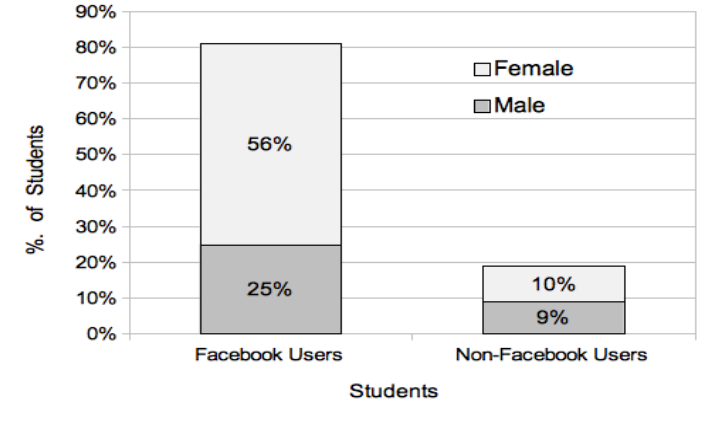
Figure 2 . Student Facebook users versus non-Facebook users.